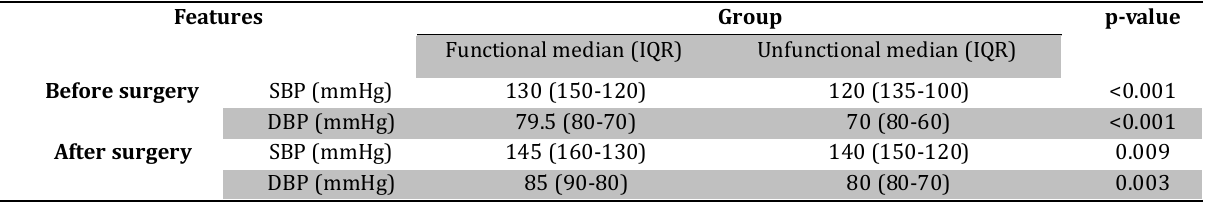
Table 3. Comparing diastolic and systolic blood pressure before and after surgery between functional and unfunctional groups.